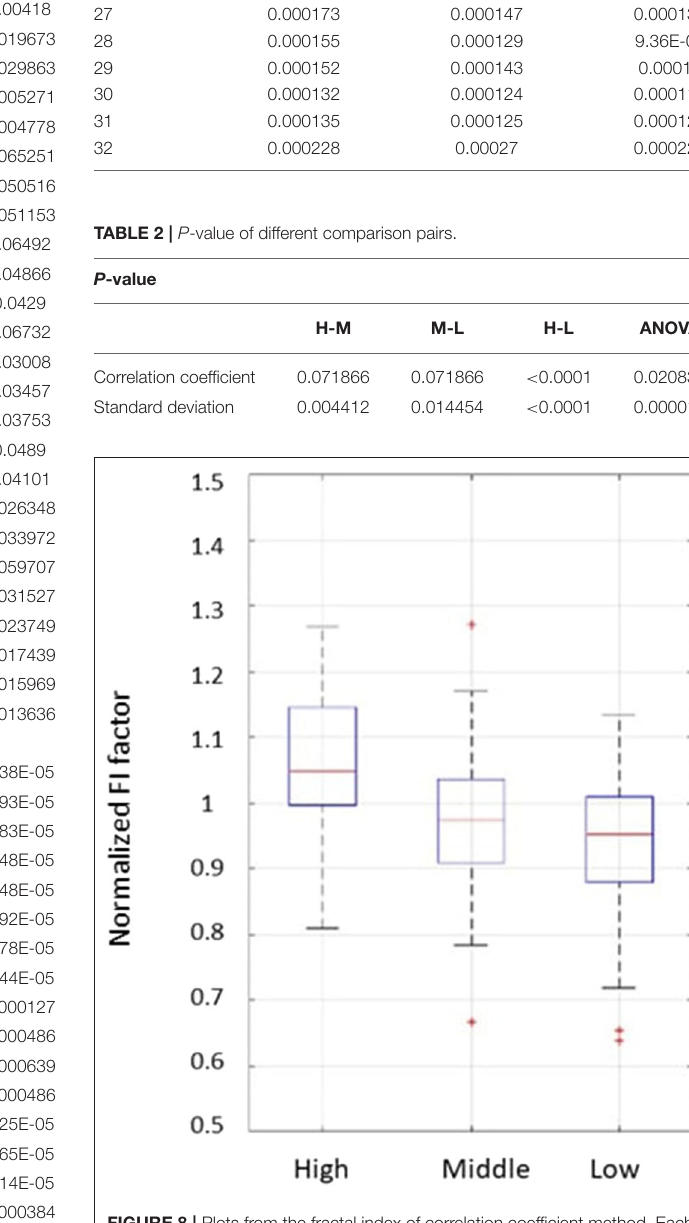
FIGURE 8 | Plots from the fractal index of correlation coefficient method. Each set of subject data was normalized by its mean value to eliminate fluctuations caused by different transducer